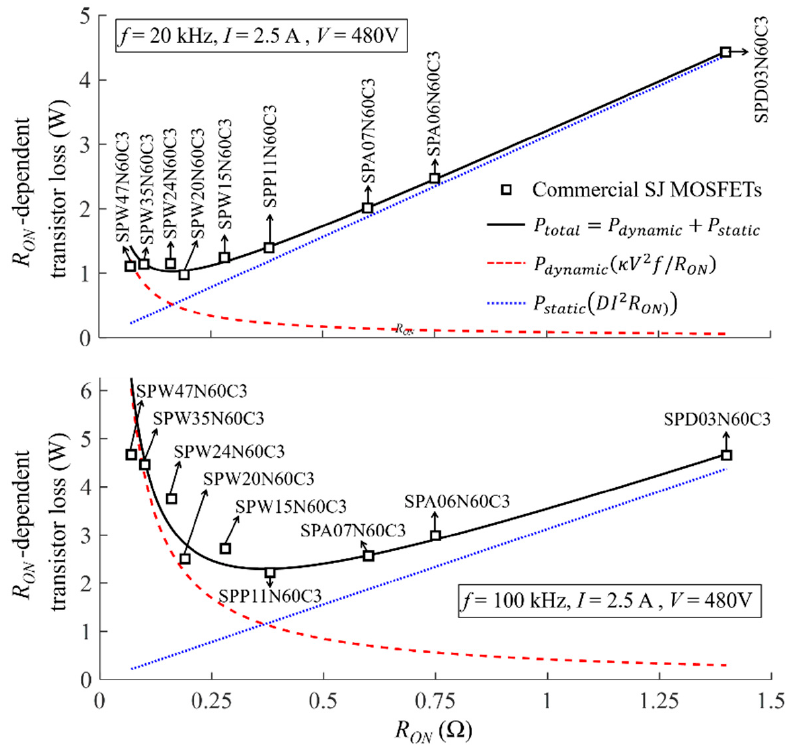
Figure 1. Comparison of the proposed theory at a constant output current of 2.5 A with the commercially available Infineon CoolMOS C3 technology SJ MOSFETs.